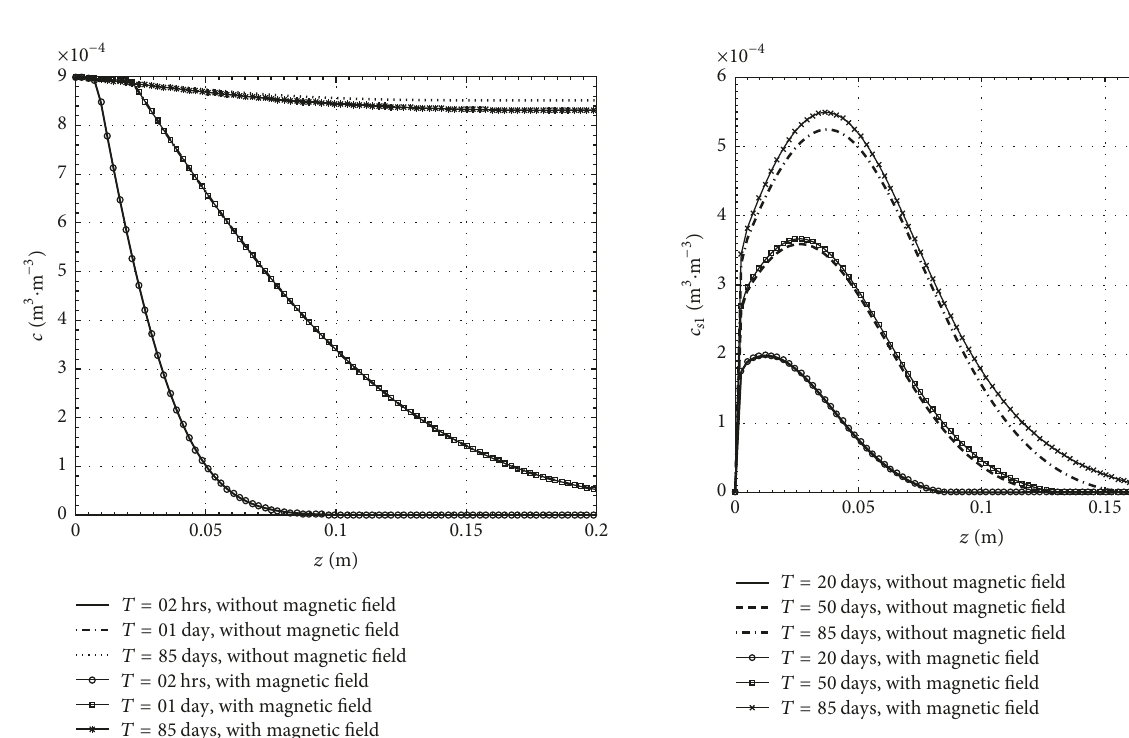
Figure 5: Nanoparticles concentration against core length with and without magnetic field effect for various values of imbibition time: magnet is placed on the right side of the core.